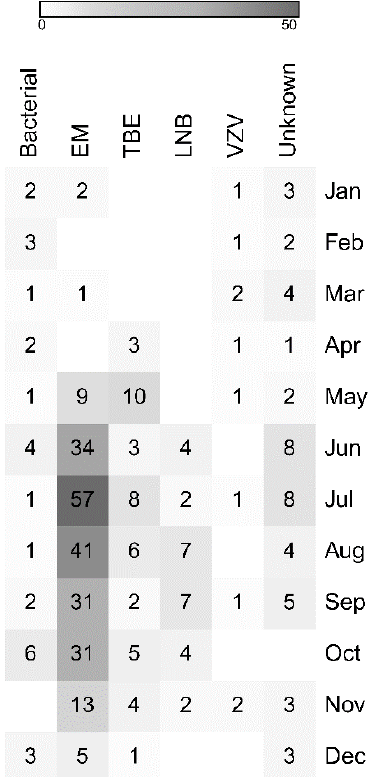
Figure 2. Yearly distribution of cases included in the study. Abbreviations: LNB: Lyme neuroborreliosis; TBE: tick-borne encephalitis; EM: enteroviral meningitis.